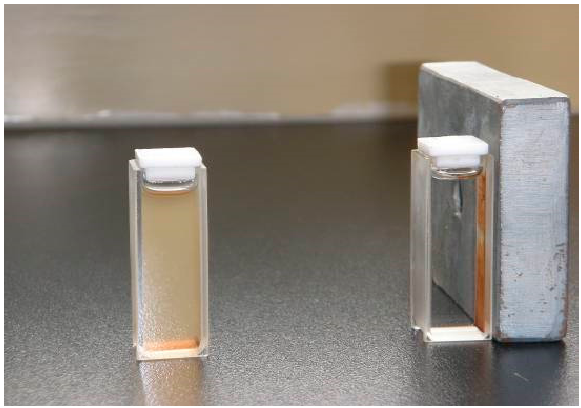
Figure 5. Vibration sample magnetometer (VSM) magnetization curves of ( a ) Fe 3 O 4 nanoparticles; ( b ) SMN and ( c ) DAPD-SMN measured at 300 K.